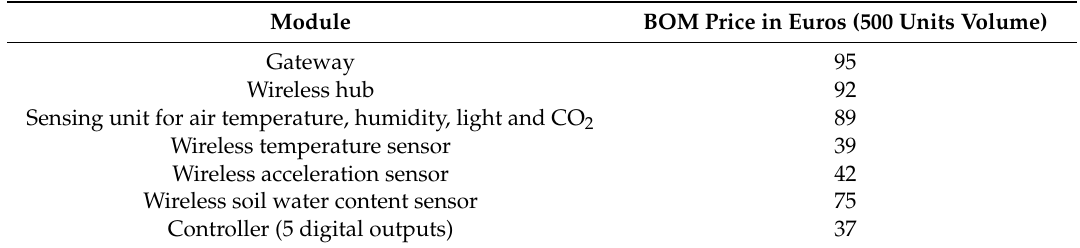
Table 8. Estimated values for the bill of materials (BOM) of the network nodes, as of March 2020. Module